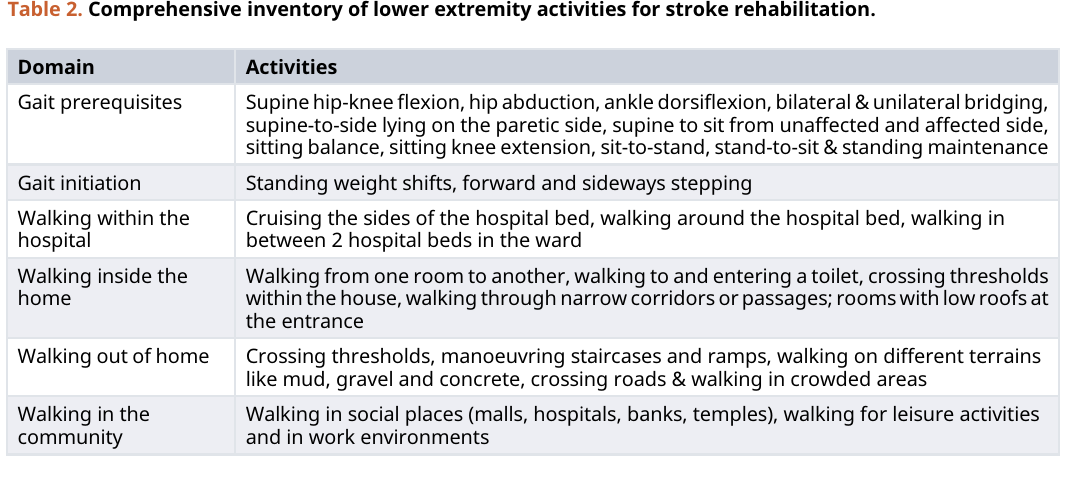
Table 2. Comprehensive inventory of lower extremity activities for stroke